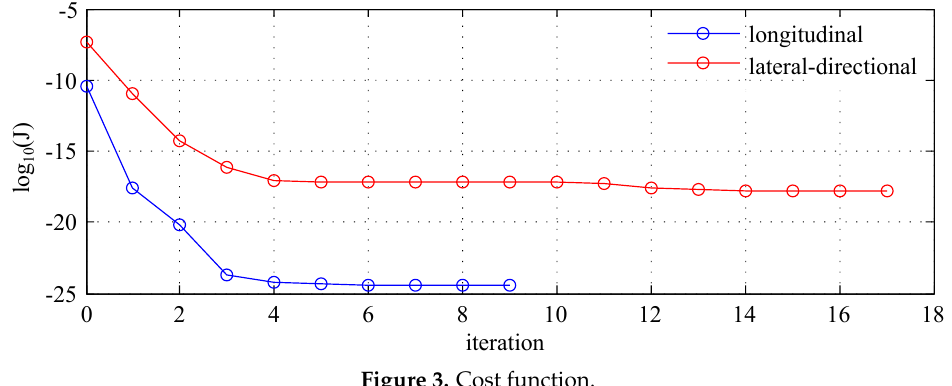
Figure 3. Cost function.